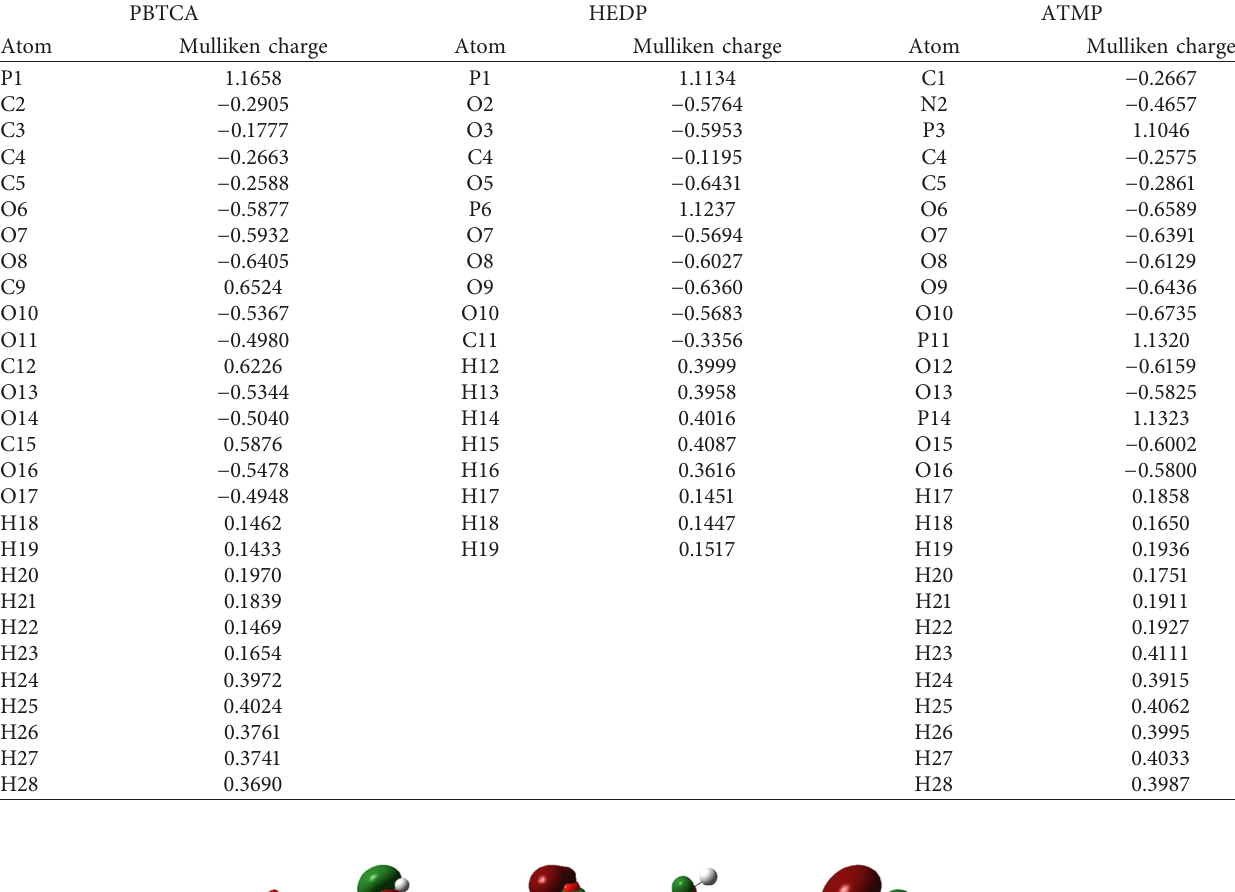
Table 2: The charge distribution of the Mulliken atom in the three corrosion inhibitors.